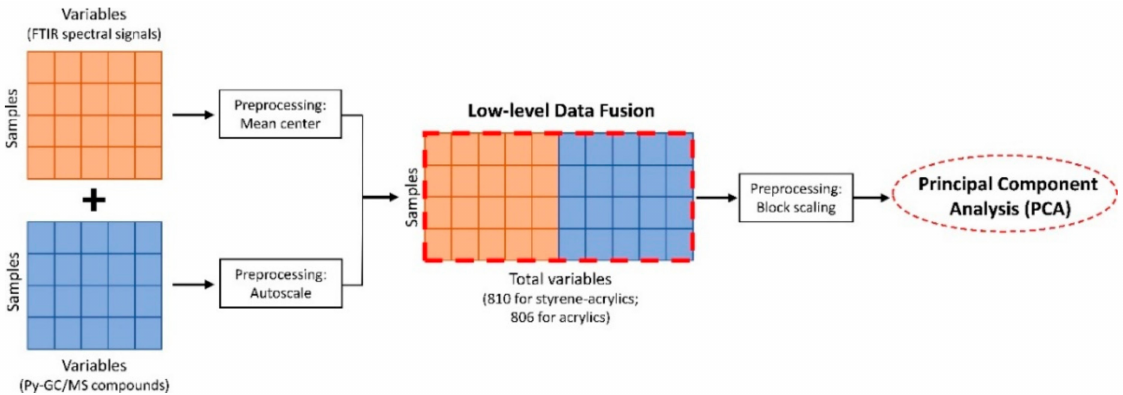
Figure 1. Schematic representation of the Data Fusion workflow used to evaluate FTIR and Py- GC/MS data